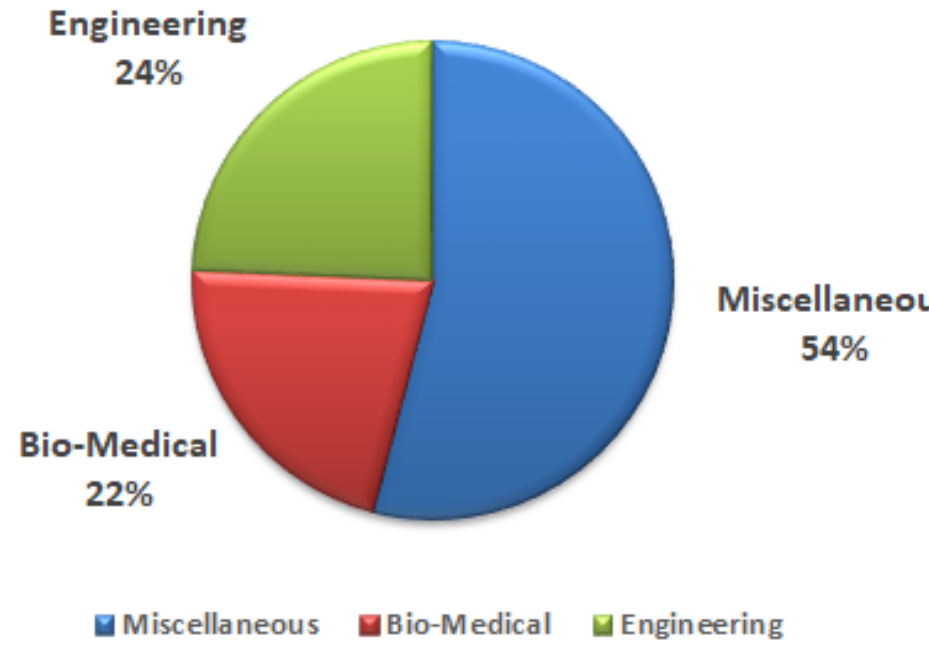
Figure 5. Distribution of papers according to application area.